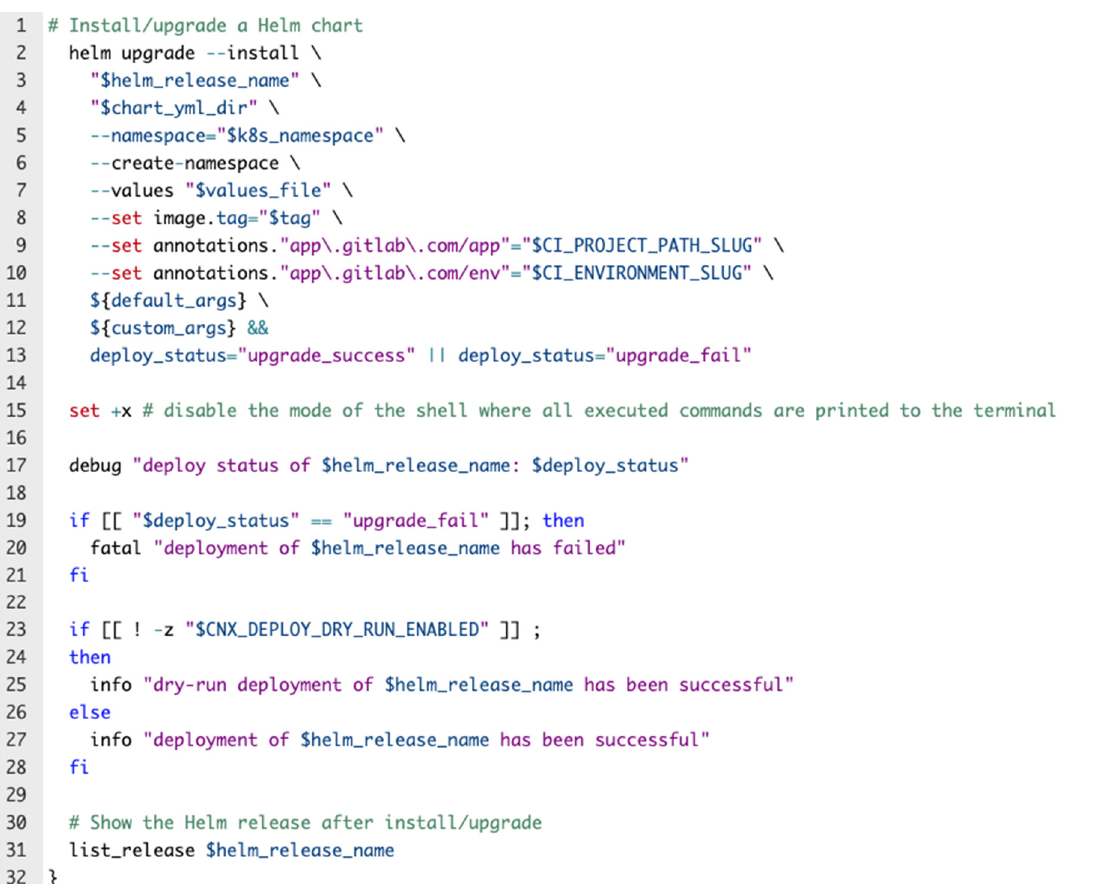
Figure 11. Helm installation/upgrade